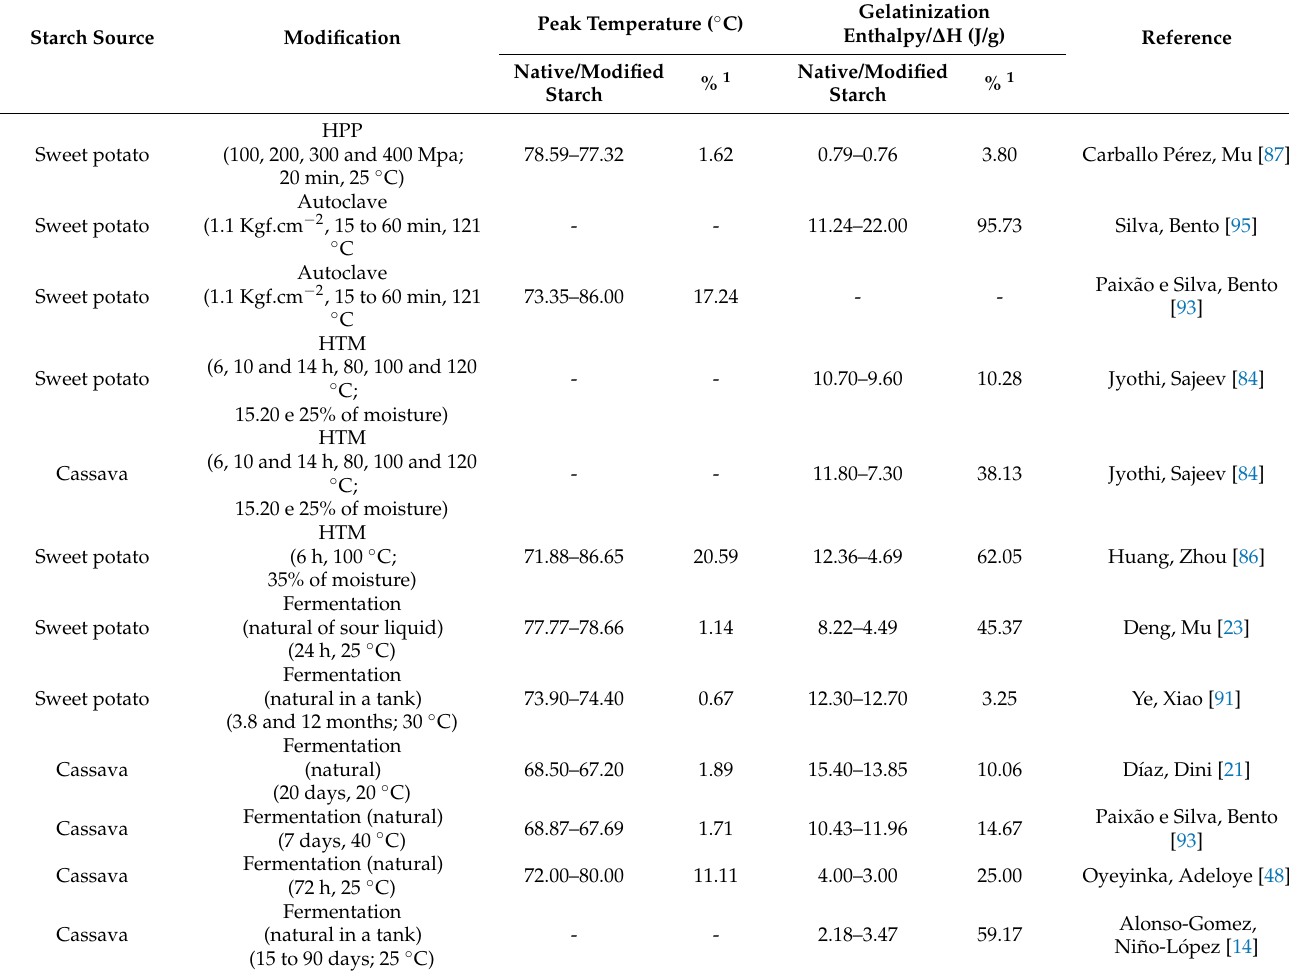
Table 4. DSC parameters (peak temperature and gelatinization enthalpy- ∆ H) of native and modified starches by high hydrostatic pressure (HPP), heat moisture treatment (HTM), autoclave, and